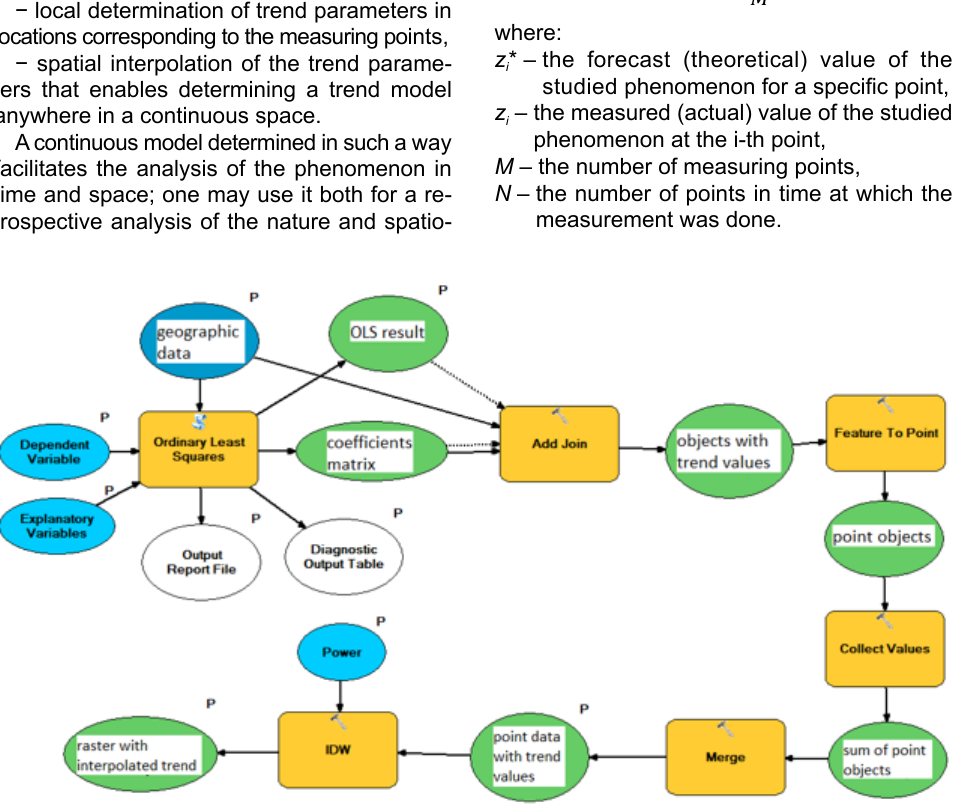
Fig. 3. The flowchart of the trend analysis tool made in ModelBuilder (source: Jackowska, 2020)